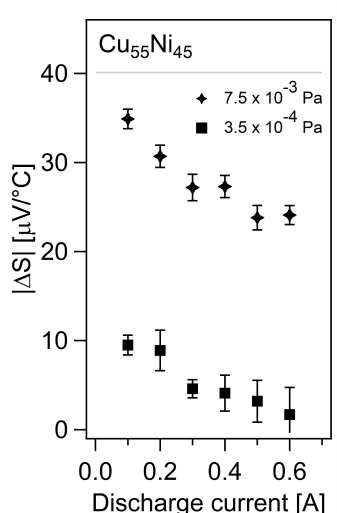
Figure 3. The deviation of the thin film Seebeck coefficient from the bulk value measured as function of the discharge current for 2 different background pressures: 3.50 × 10 − 4 Pa (square markers) and 7.50 × 10 − 3 Pa (diamond markers). The argon pressure was set to 0.6 Pa and the target-to-substrate distance was 10 cm. The full gray line indicates the maximal deviation | ∆ S | max